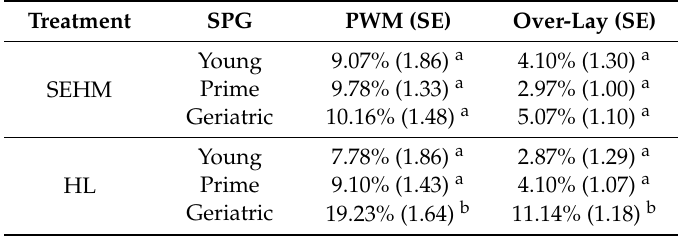
Table 2. Interaction of treatments (SEHM and HL) and sow parity group (SPG) for PWM and over-lay percentage. Levels not connected by the same superscript letter are significantly di ff erent ( α =